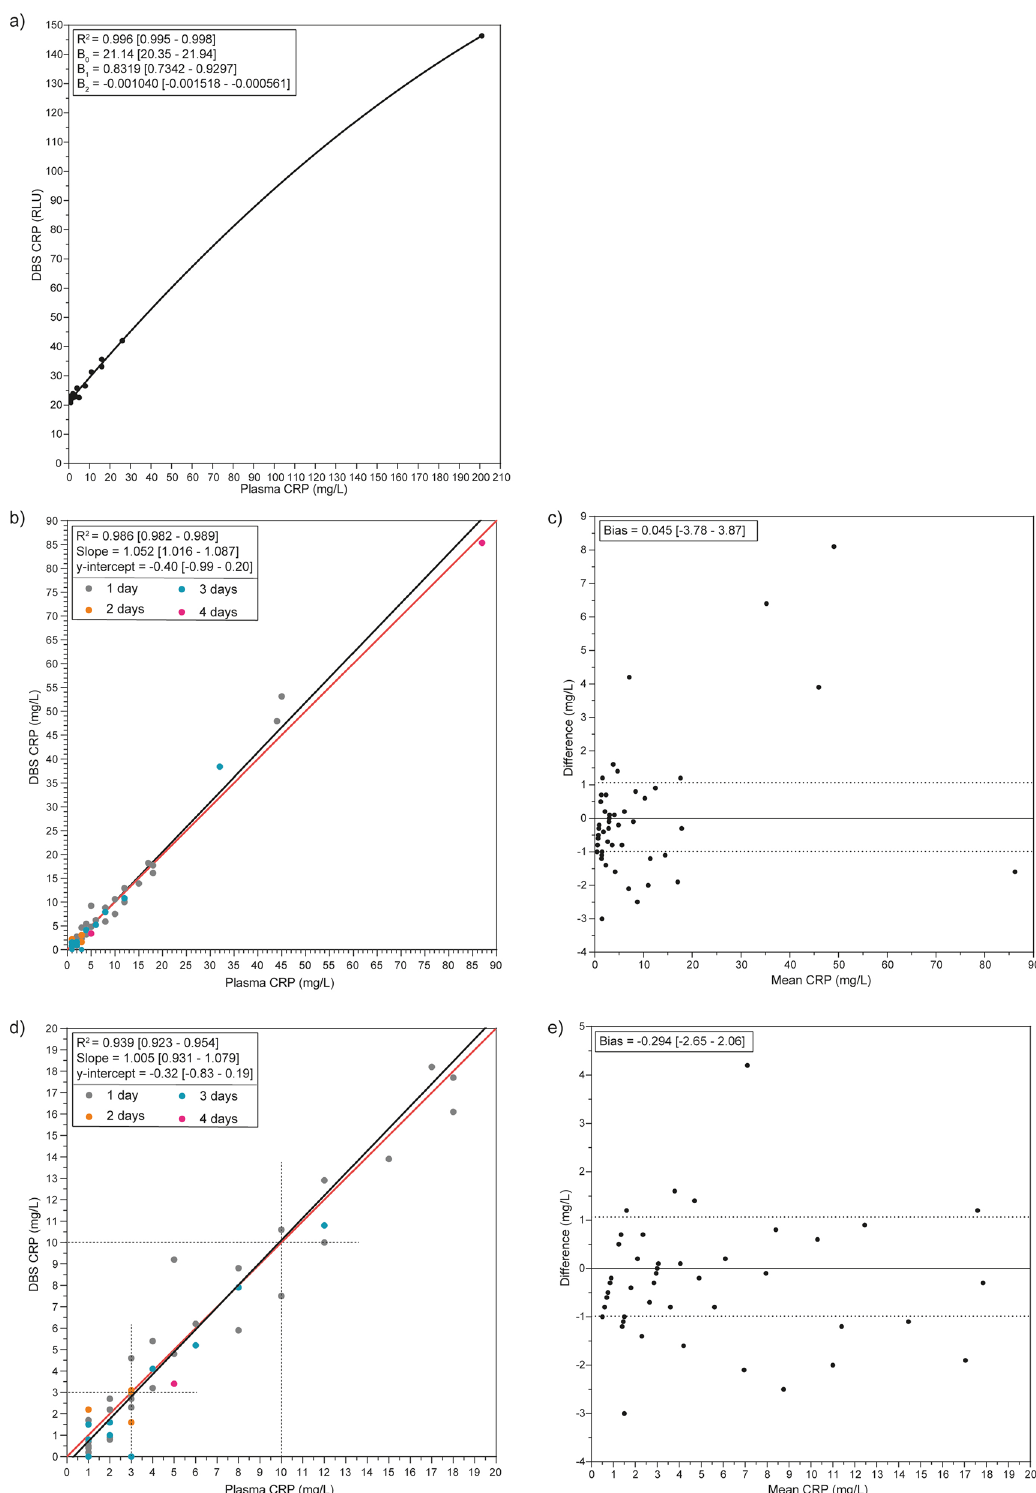
Figure 1. CRP method comparison. ( A ) Calibration line for DBS CRP, calibration line was calculated with second-order polynomial regression; n = 19. ( B ) Method comparison for DBS CRP with the line of identity (red) and Deming linear regression (black). Storage time of DBS cards is displayed in grey (1 day, n = 34), orange (2 days, n = 4), blue (3 days, n = 13), and pink (4 days, n = 2); total n = 53. ( C ) Bias plot from method comparison of panel ( B ). ( D ) Method comparison for DBS CRP in the near normal range with the line of identity (red), Deming linear regression (black), and cut-off values for diagnosis (black dotted lines). Storage time of DBS cards is displayed in grey (1 day, n = 32), orange (2 days, n = 4), blue (3 days, n = 16), and pink (4 days, n = 1); total n = 49. ( E ) Bias plot from method comparison of panel ( D ). All 95% confidence intervals are shown in between